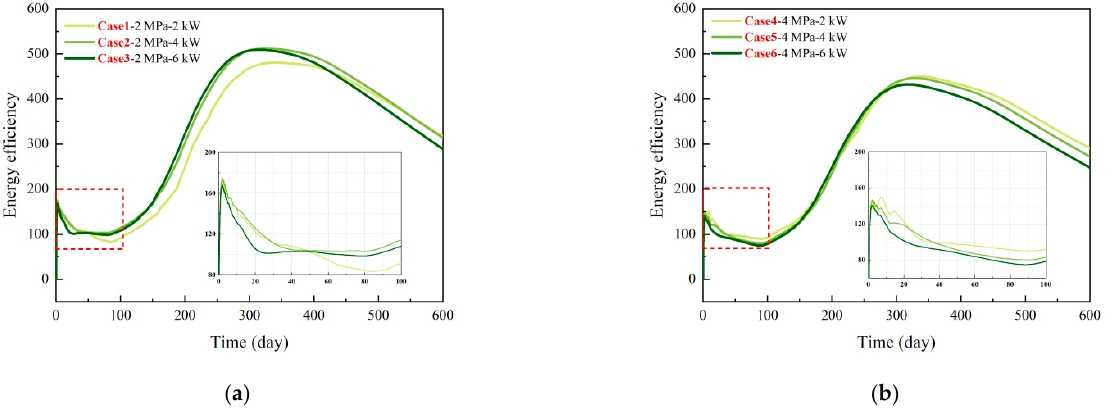
Figure 12. Evolution of energy efficiency: ( a ) production pressure of 2 MPa; ( b ) production pressure of 4 MPa.